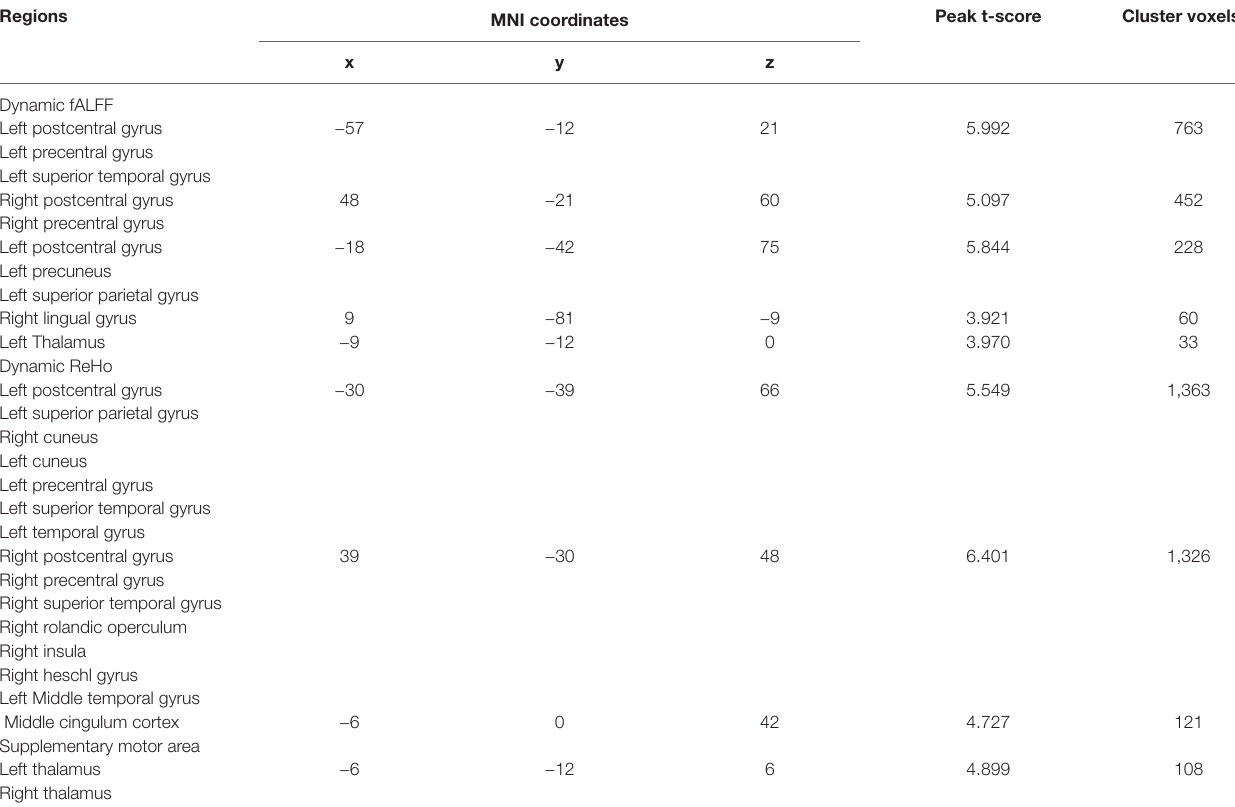
TABLE 2 | Significant increased dynamic fALFF and ReHo in schizophrenic subjects.